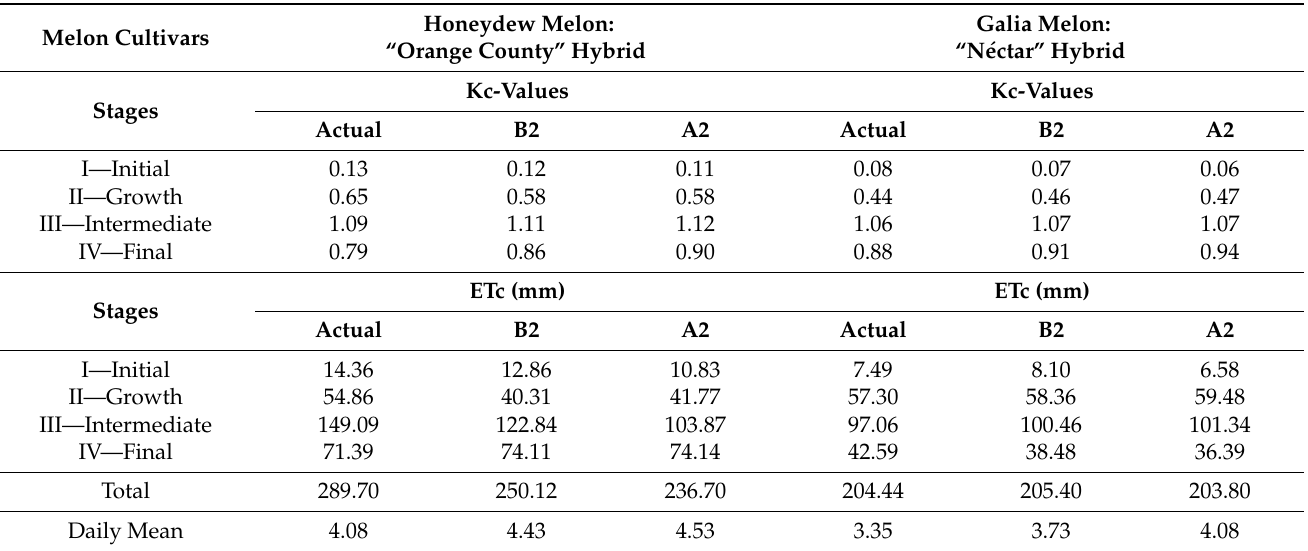
Table 5. Melon cultivars’ crop coefficient values (Kc) and crop evapotranspiration (ETc) for the Intergovernmental Panel on Climate Change’s emission